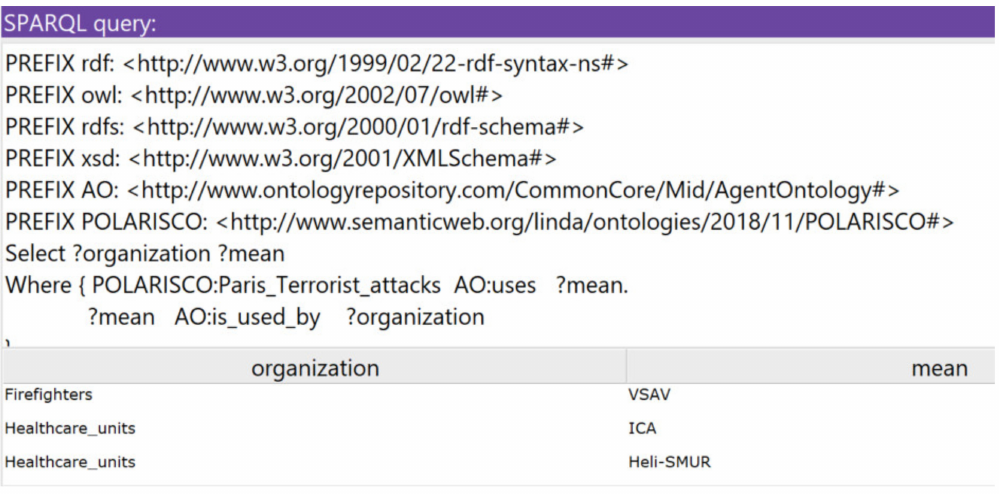
Figure 22. SPARQL query and results of the used means by firefighters and healthcare units.